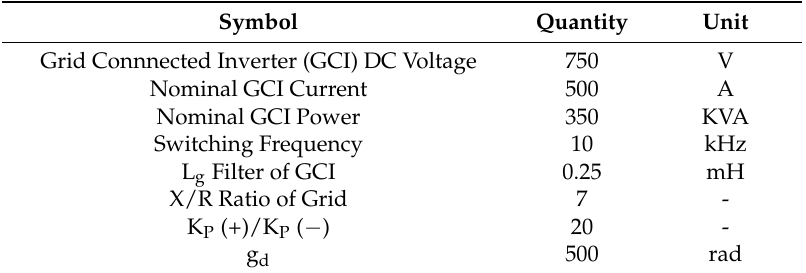
Table 1. Parameters used in